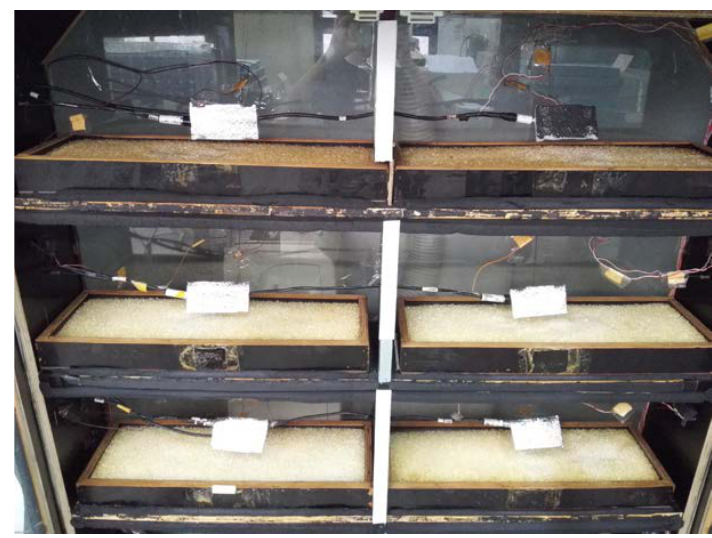
Figure 4. Image of the desiccant modules embedded in the window.